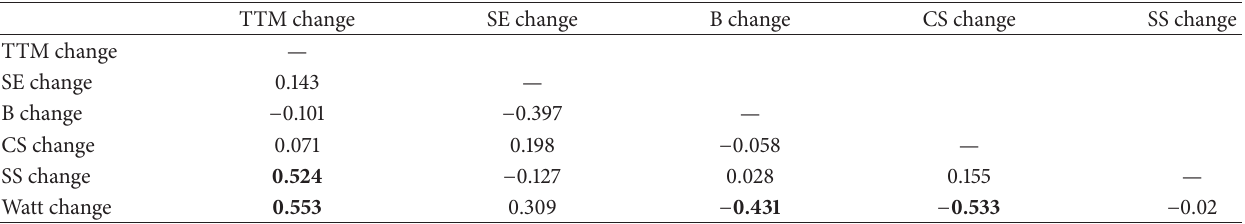
Table 3: Correlations of the changes in motivational variables and the change in performance in the exercise sessions for participants of the training group.